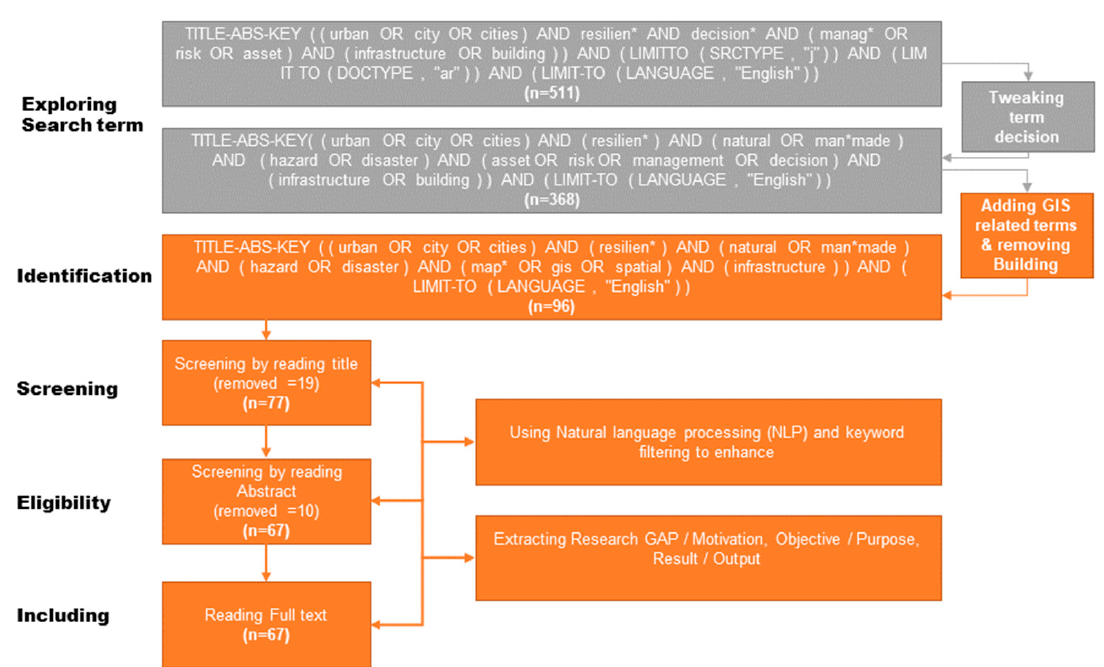
Figure 2. The PRISMA flow diagram (adapted from [98]).